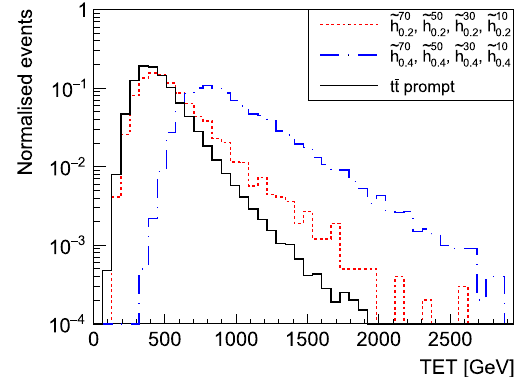
Fig. 36 Transverse momentum p T of the second leading lepton in the ˜ h 2 -like case